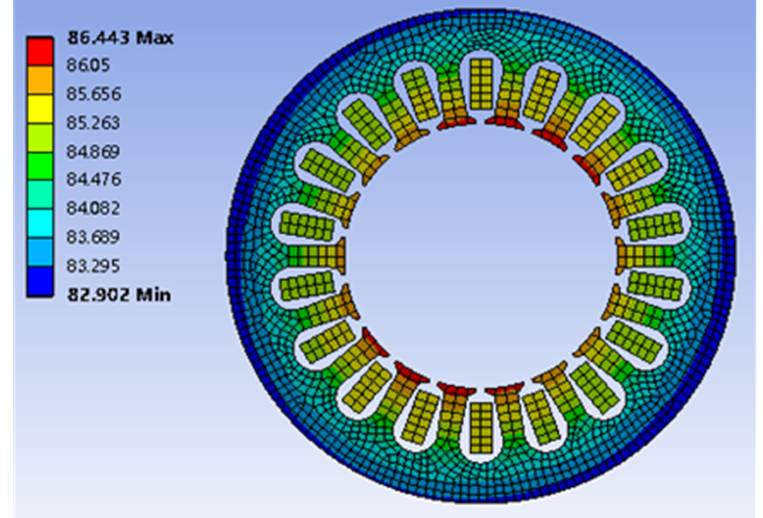
Figure 9. Stator Temperature Distribution of AA Motor.